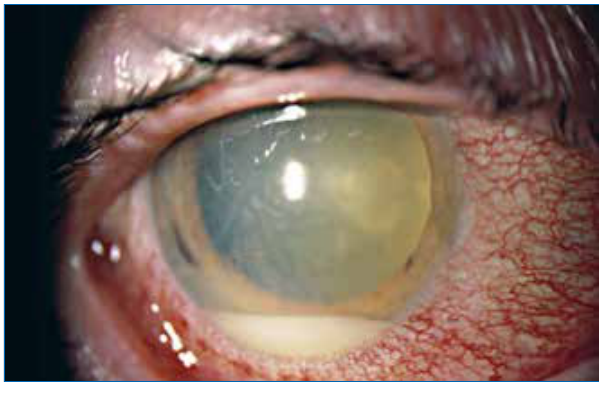
Figure 5: Endophthalmitis